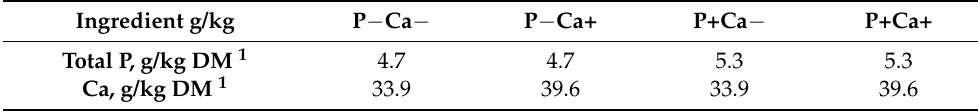
Table 1. P and Ca concentrations in the four diets of experiment 2. Values from Table 1 in Sommerfeld et al. 2020 [28]. Recommended concentrations are labelled with +, reduced concen- trations with −